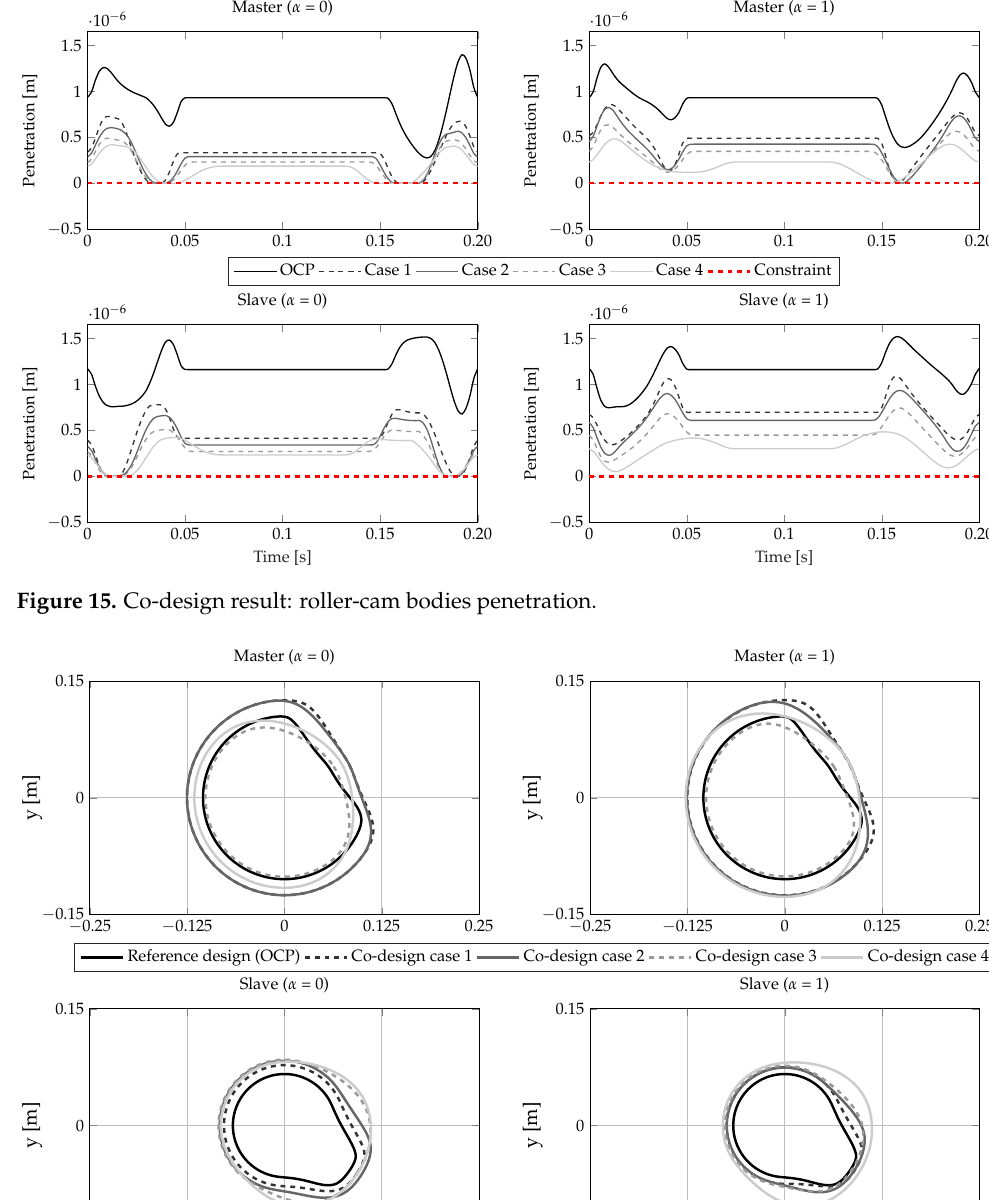
(cid:104) (cid:105) 0 1